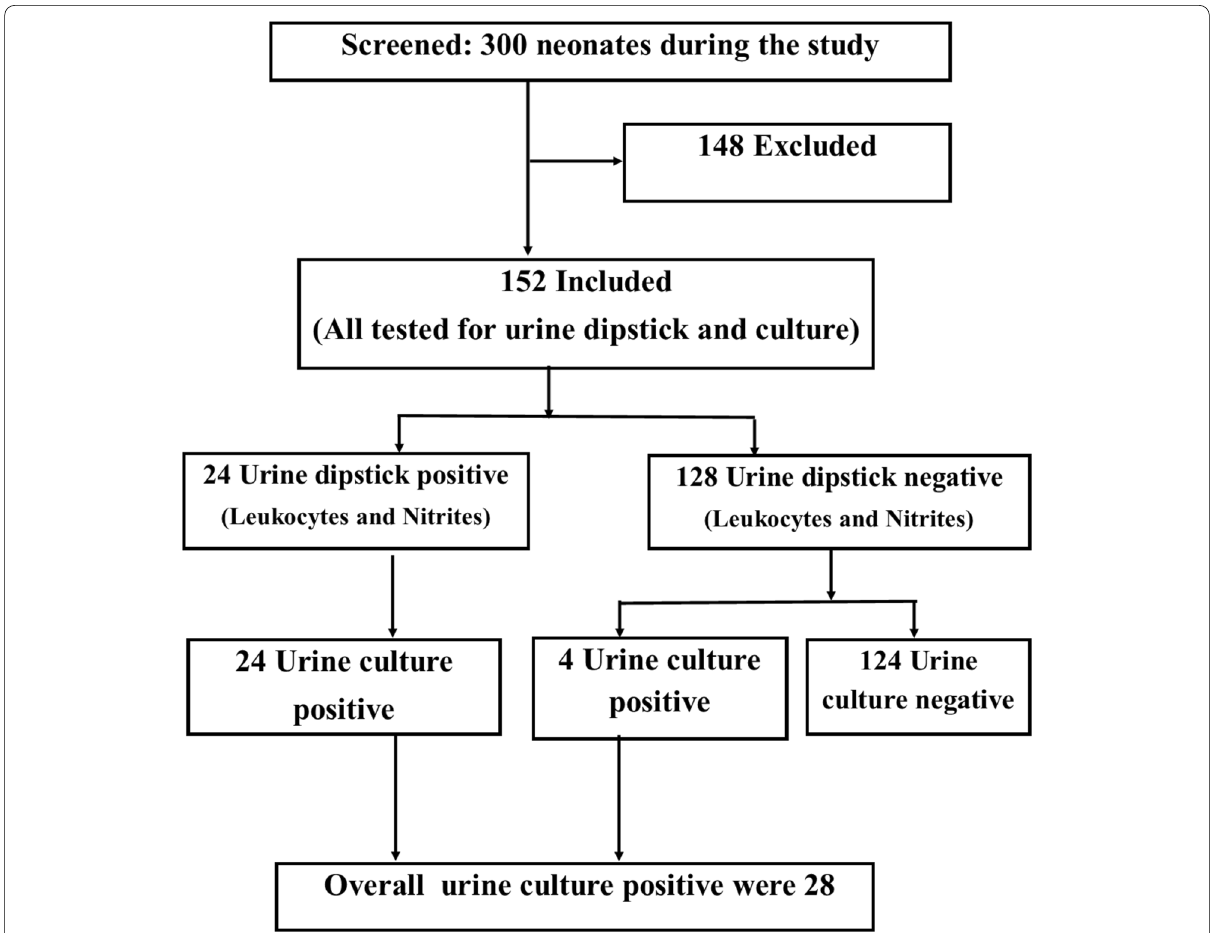
Fig. 1 Flow chart indicating selection of the study